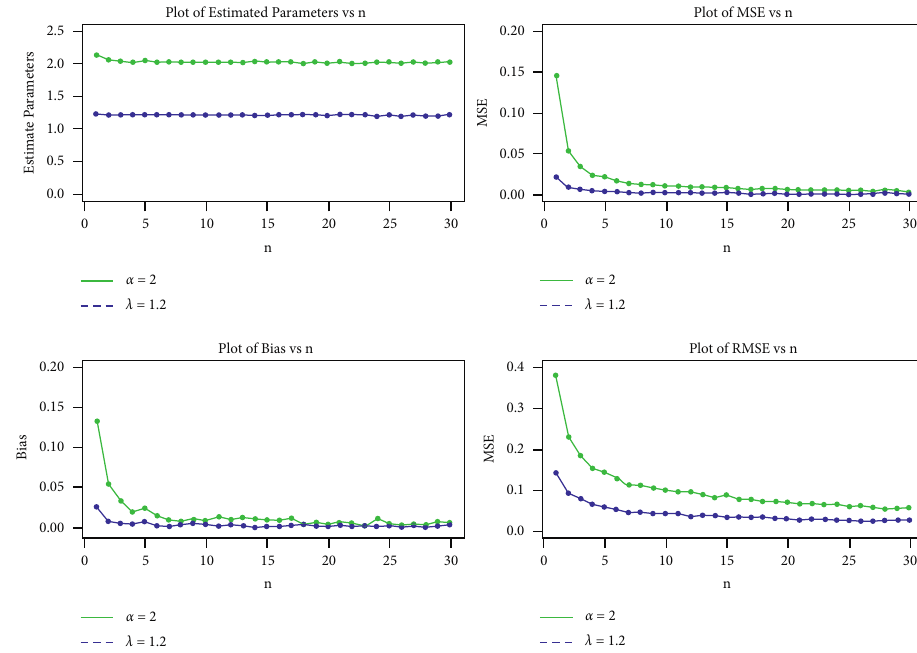
Figure 6: Visual representation of the MC simulation outcomes given in Table 4.